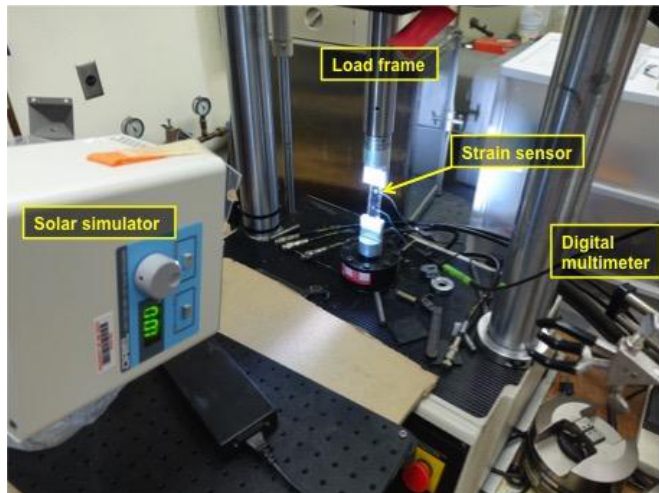
Figure 4. The flexible strain sensor was tested to validate its DC voltage-based strain sensing capability under tensile loading and unloading cycles while measuring DC voltage under one-sun